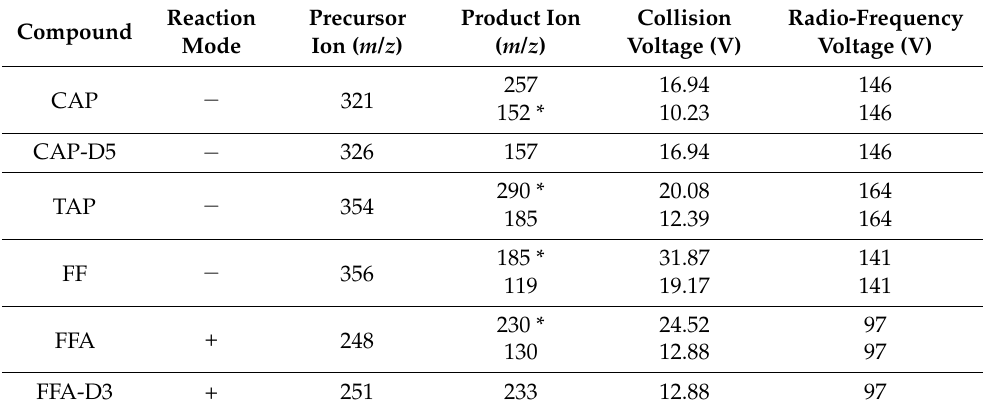
Table 3. Mass spectrometry parameters of amphenicols and